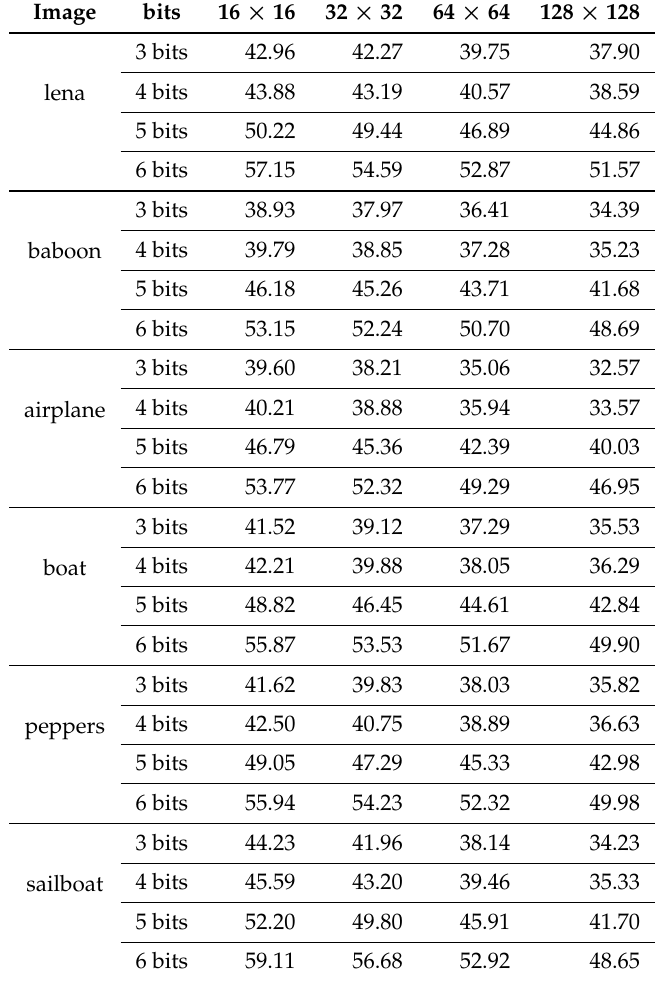
Table 2. The peak signal-to-noise ratio (PSNR) value on different image with different measurements. Image